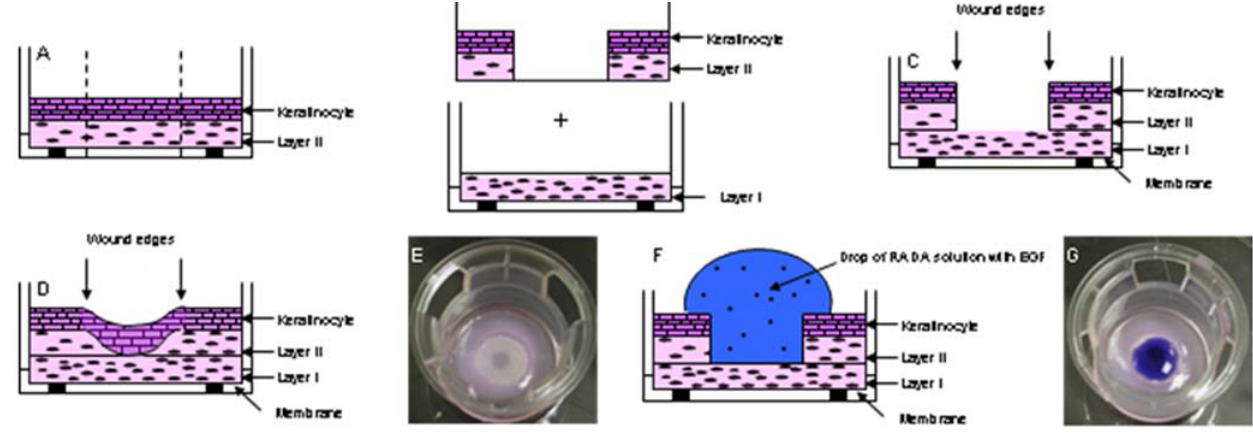
Figure 2. Construction of composite organotypic co-culture wound healing model. A) Schematic drawing of stratified keratinocyte sheet growing on contracted collagen matrix containing fibroblasts (Layer II). This skin equivalent culture rests on a semi-permeable membrane and is nourished with medium from below, thus being exposed to an air-liquid interface. A wound is formed by punching a hole through the epithelium and collagen matrix. B) the wounded culture is transferred onto a second collagen matrix that has undergone contraction (Layer I). C) the resultant composite co- culture consists of two layers of contracted matrix and one layer of epithelium. Wound edges are seen at the transition zone from layer I to layer II and are noted with arrows. D) reepithelialization occurs as wounded keratinocytes migrate onto the collagen in layer II and is then followed by stratification of the tissue to reconstitute a fully stratified epithelium that covers the wound bed. E is a picture of the wound as depicted in C. on top of the wound a drop of self-assembling peptide containing or not the protein is added (scheme F). G is a picture of the wound covered by the drop of